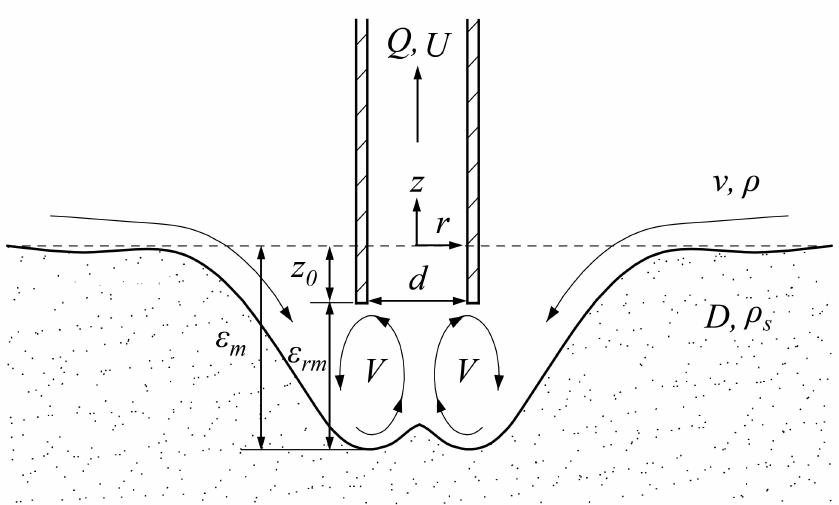
Figure 1. Diagrammatic sketch of erosion by suction